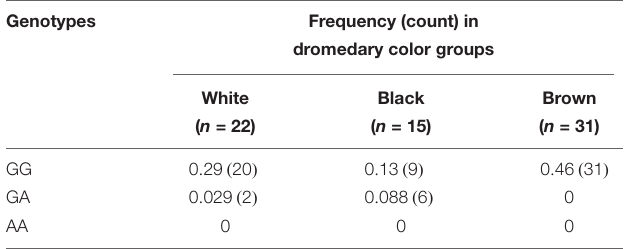
TABLE 5 | Genotype frequencies of MC1R c.901C > T missense mutation in a large study cohort ( n = 188). Genotypes